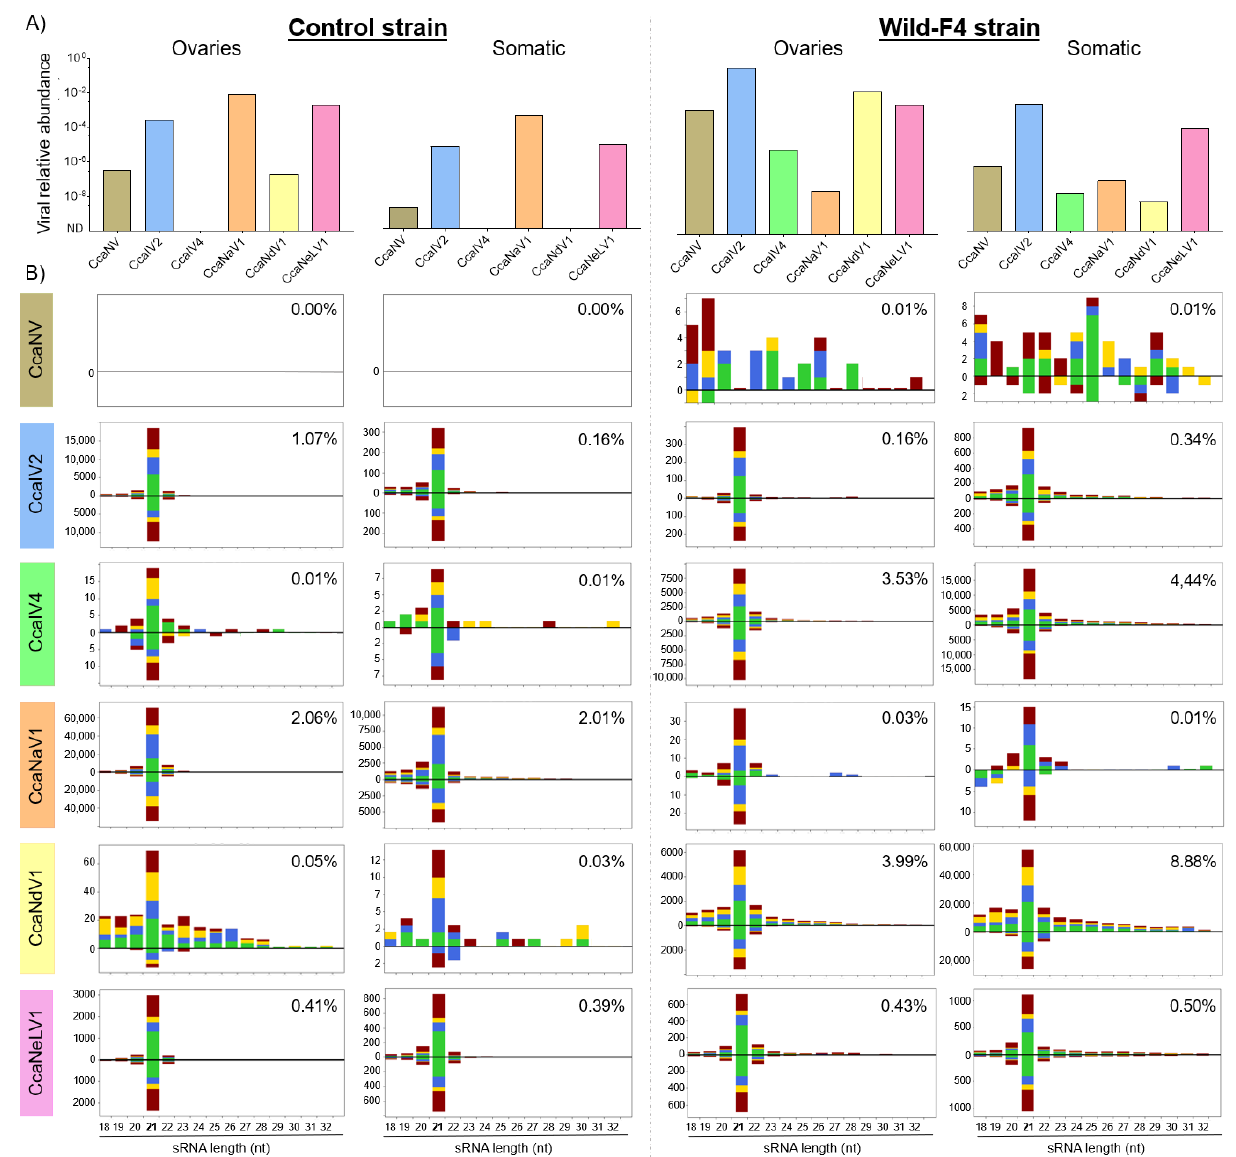
Figure 4. Viral relative abundance and small RNA profile of six positive ssRNA viruses in ovaries and somatic tissues of the control and Wild-F4 medfly strains. ( A ) The relative abundance of the six viruses was calculated using qPCR and referred to the expression of the endogenous L23a gene. ( B ) Size distribution of 18- to 32-nt small RNAs mapping to the viral genome of each of the six viruses. Positive-strand reads are displayed above the solid horizontal line, negative-strand reads are below. Percentages show the number of unique reads mapping to each of the viral genomes in comparison to the total unique sRNA reads account for each sRNA library. Colors indicate the first nucleotide of the sRNA read (red = U, green = A, blue = C, yellow =